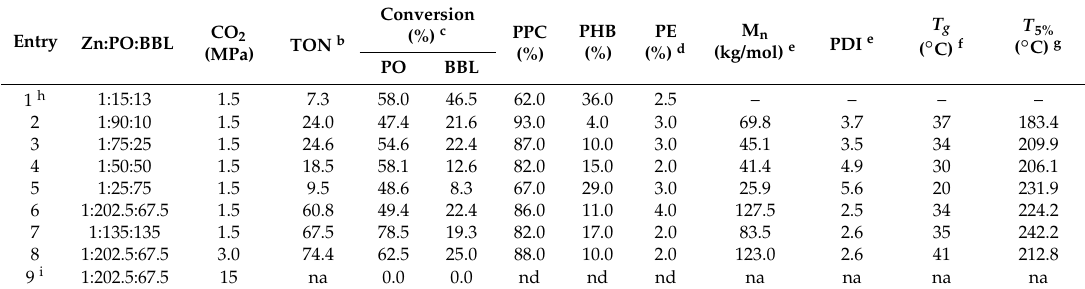
Table 1. Terpolymerization of PO, CO 2 , and BBL using ZnGA-20 a